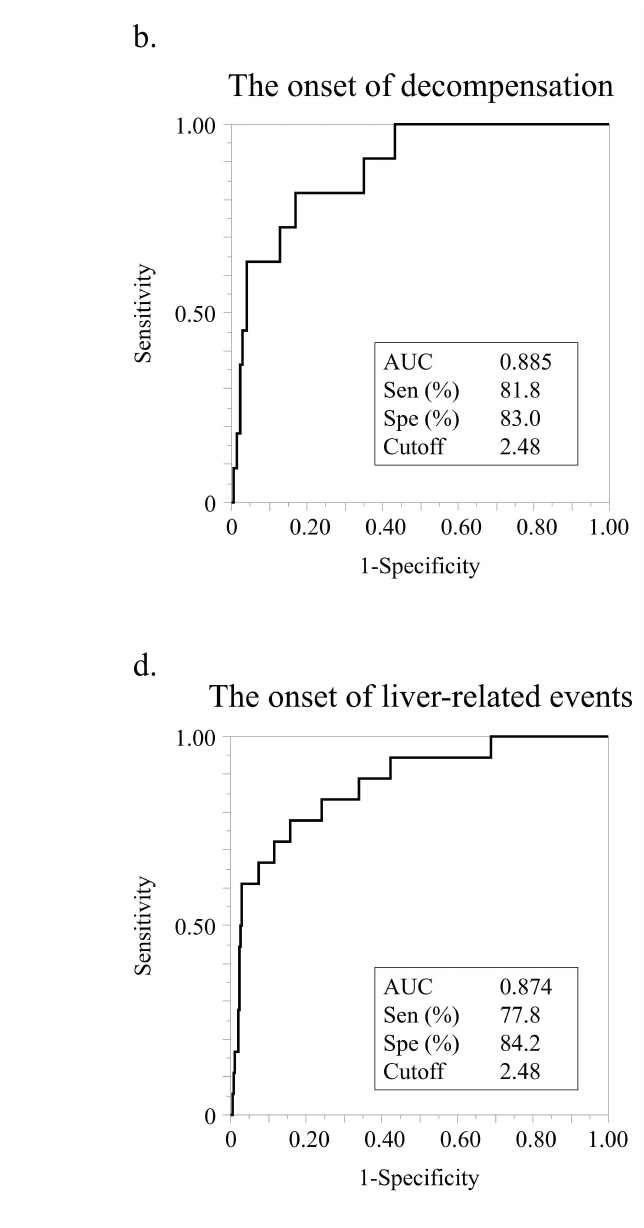
Figure 3. ROC analysis of FIB-4 index for liver-related events. ( a ) ROC analysis of FIB-4 index for HCC development. ( b ) ROC analysis of FIB-4 index levels for decompensation development. ( c ) ROC analysis of FIB-4 index for bleeding gastroesophageal varices development. ( d ). ROC analysis of FIB-4 index for LRE